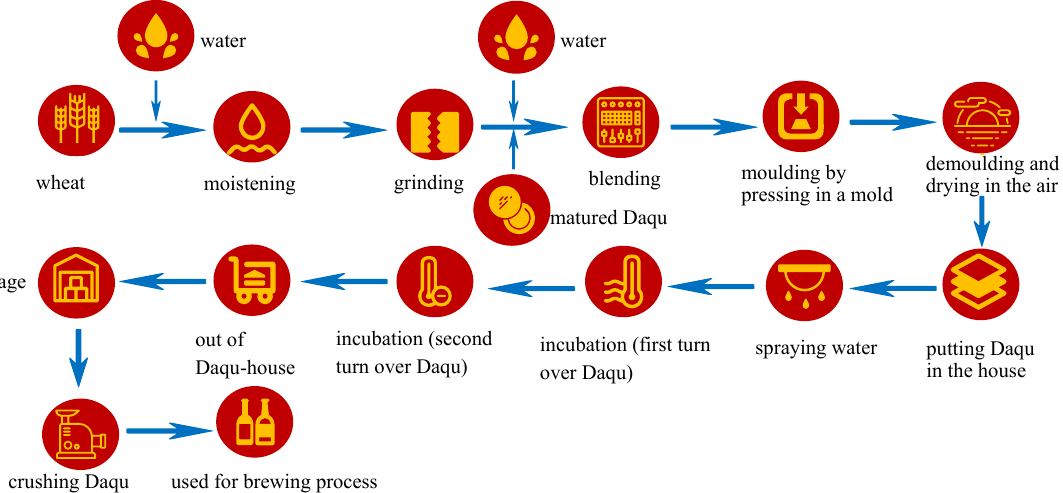
Figure 5. The process of producing high-temperature Daqu .